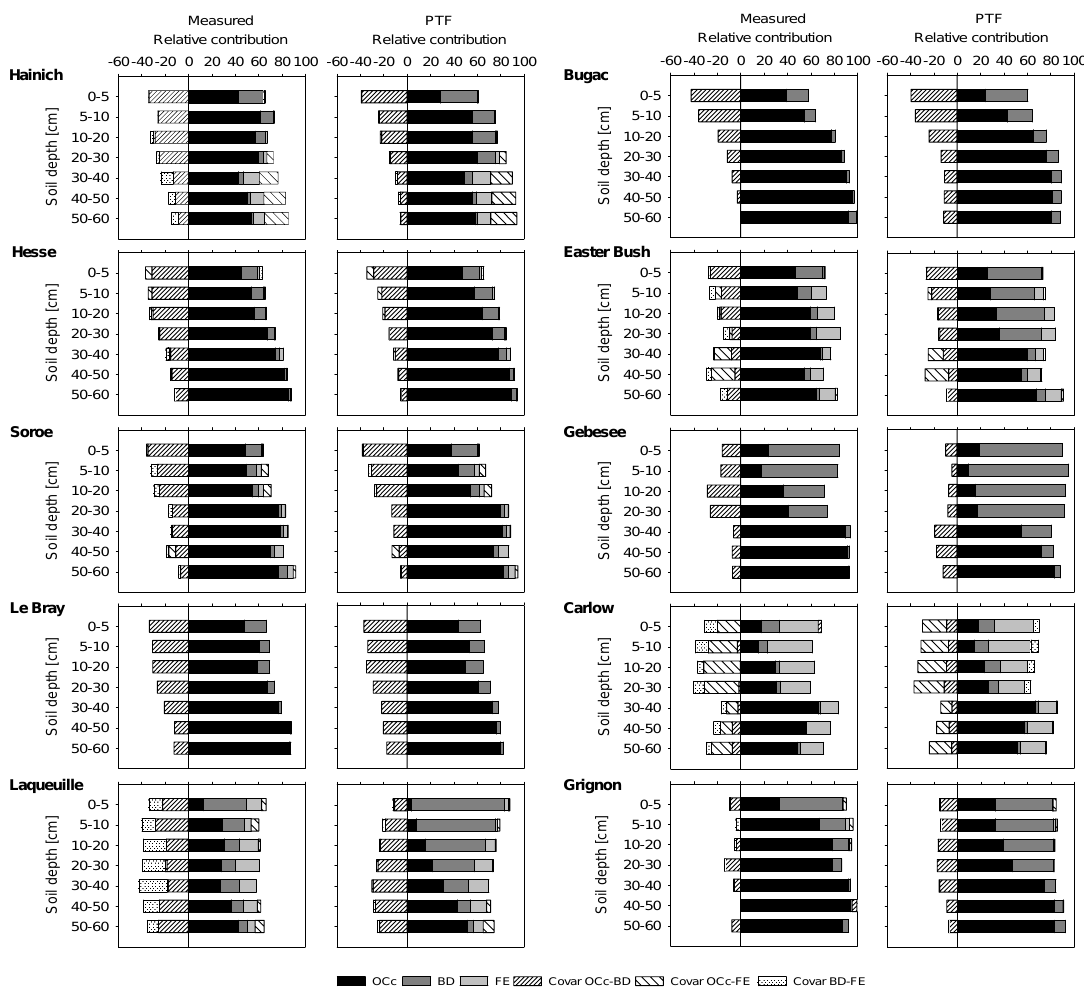
Fig. 5. Relative contribution of OC concentration (OCc), bulk density (BD), fine earth content (FE), and the covariances between OCc and BD, OCc and FE, and BD and FE to the variance of OC stocks (soil depth in cm, relative contribution in